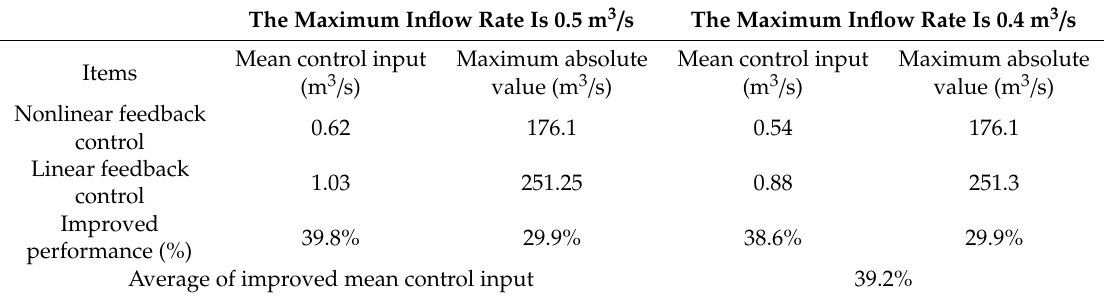
Table 1. Comparison of linear and nonlinear performances between two algorithms.